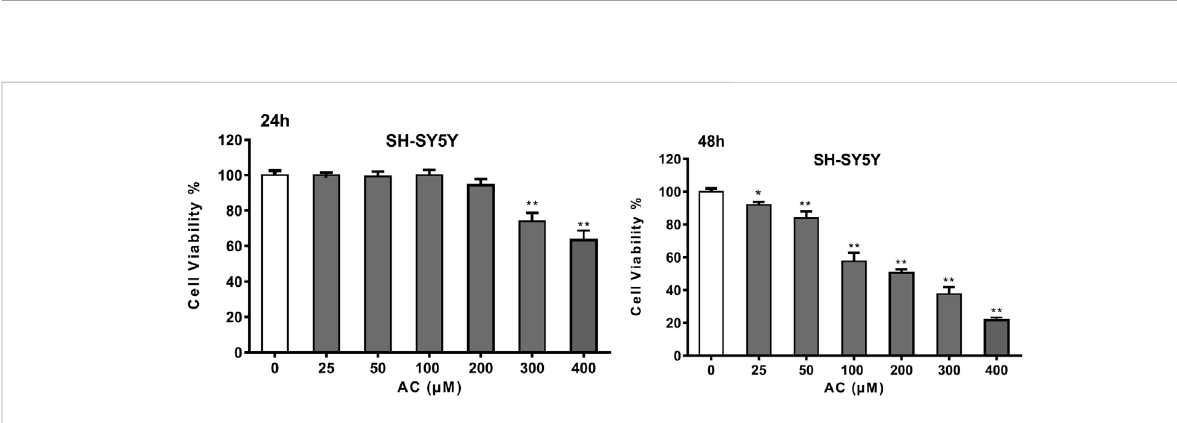
FIGURE 6 Cell Viability of SH-SY5Y cells after 24 and 48 h aconitine treatment. (* p < 0.05, ** p < 0.01 versus control